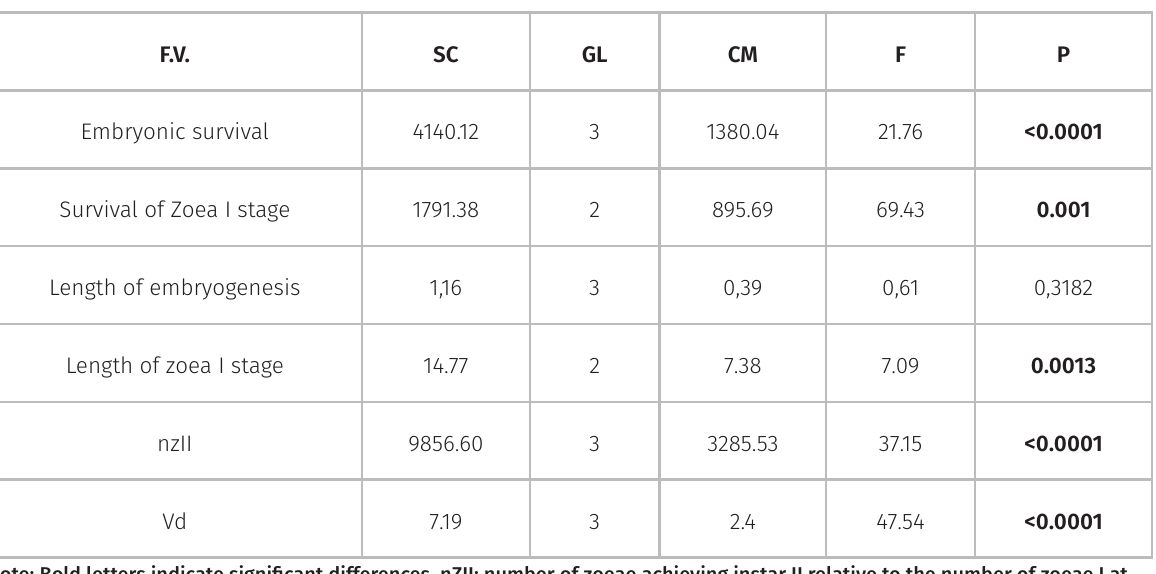
Table III. One-way ANOVA’s for different variables registered for the embryonic and first larval stage of Ovalipes trimaculatus as response to different seawater salinities.